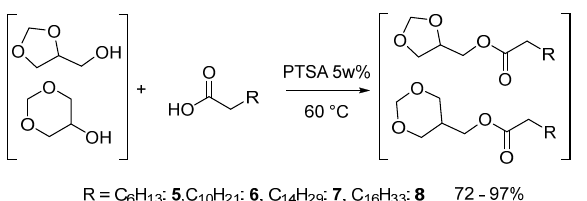
Table 1. Reactions between solketal and FFAs a